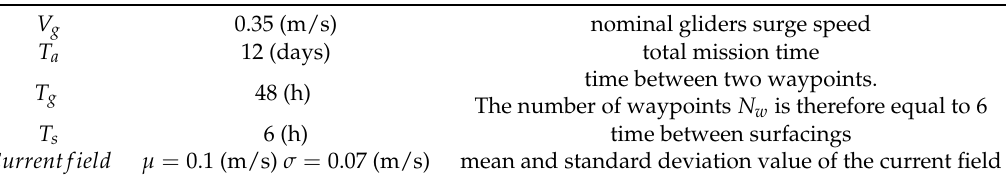
Table 2. Parameters for the missions of